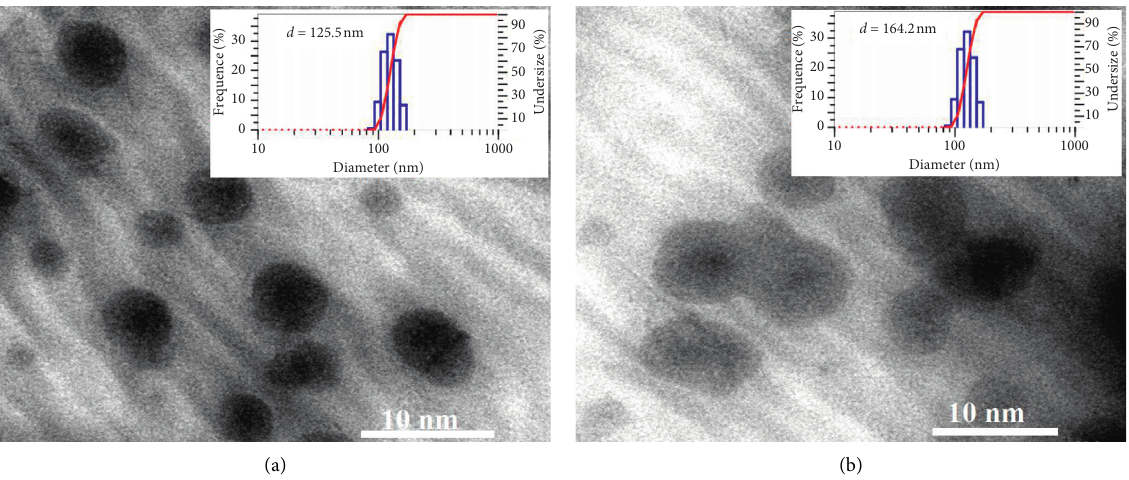
Figure 3: TEM images and DLS diagrams (insets) of ZnSe:5% Mn (a) and ZnSe:% 5 Mn/ZnS CSQDs